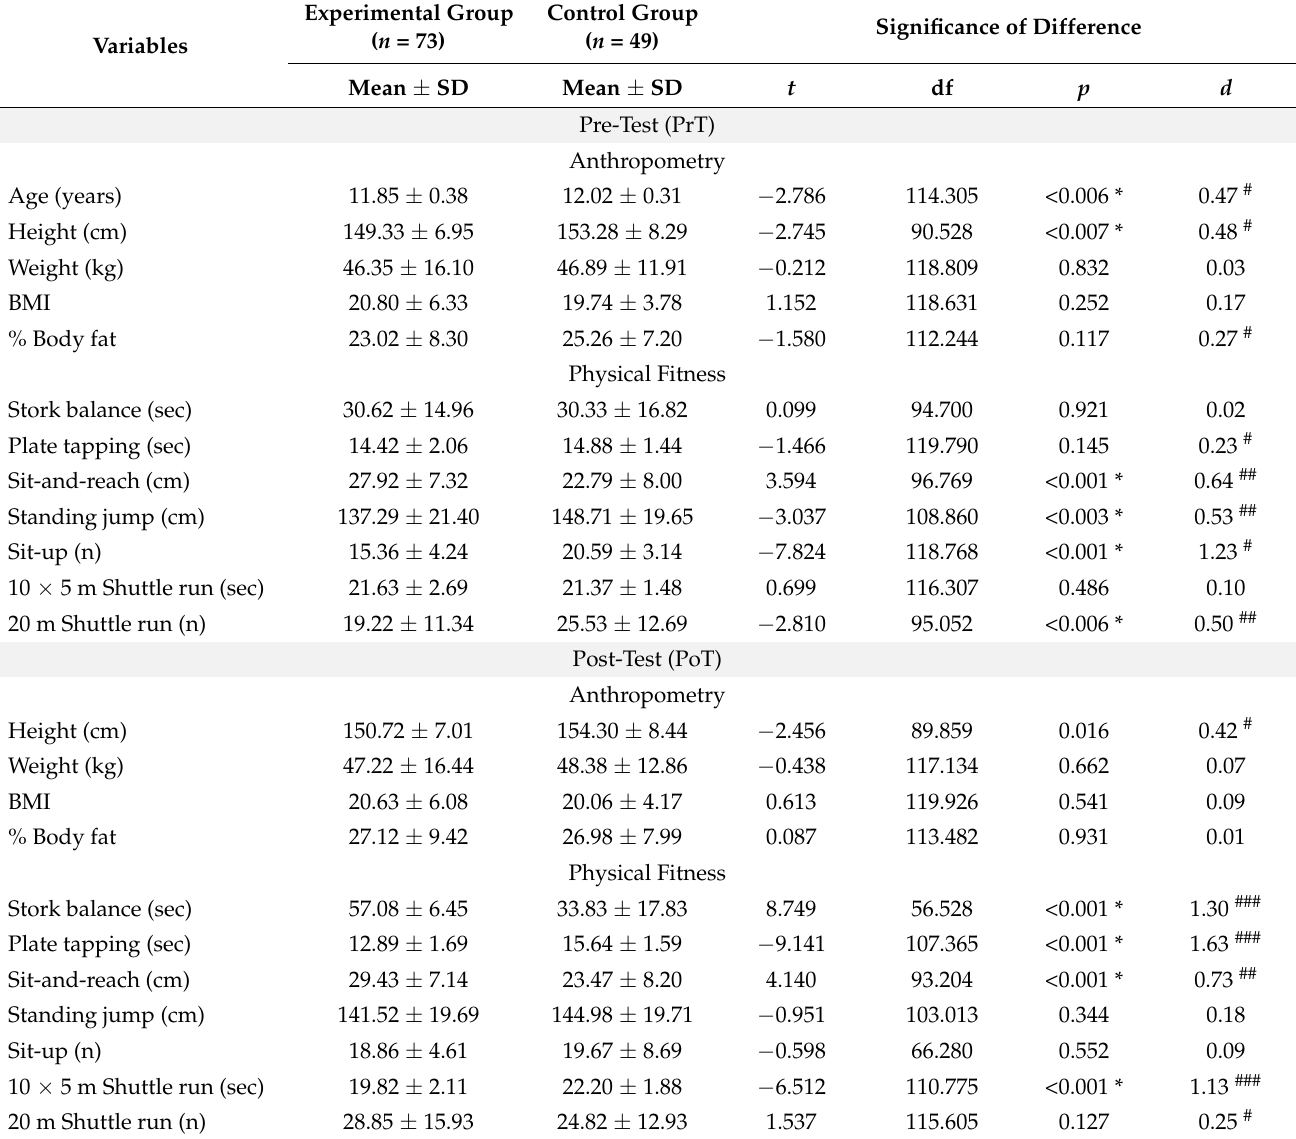
Table 2. Differences between the experimental and control group during the pre- and post-test regarding their physical fitness